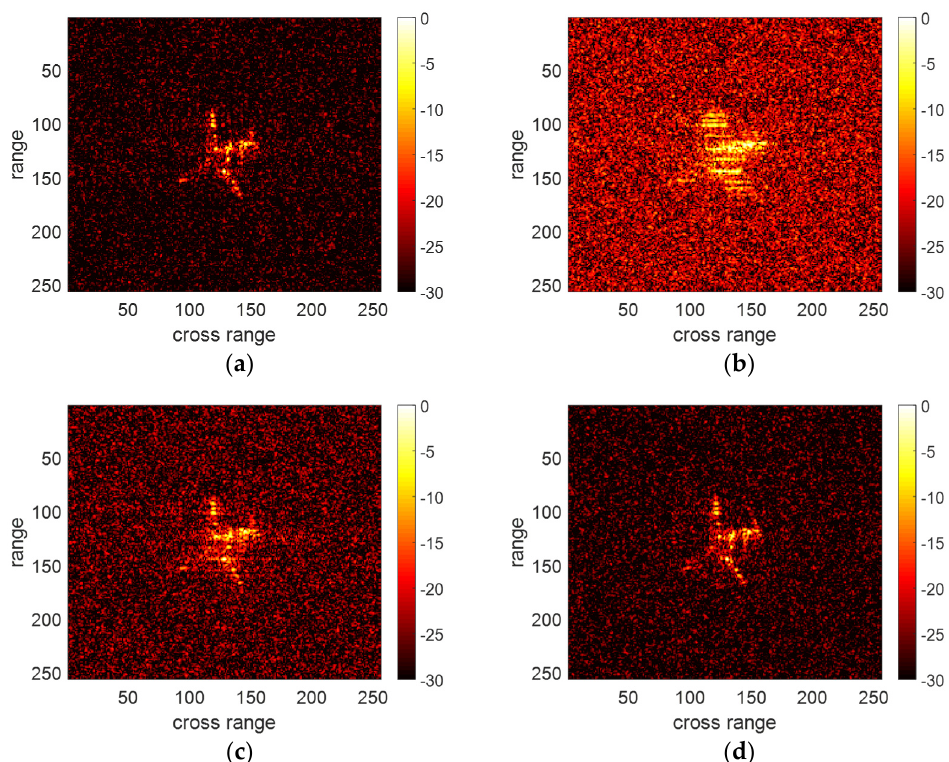
Figure 8. Translational motion compensation result of different methods under SNR = − 6 dB. ( a ) Ideal result. ( b ) Result of PSO. ( c ) Result of PD ‐ KT ‐ FrFT. ( d ) Result of the proposed method.